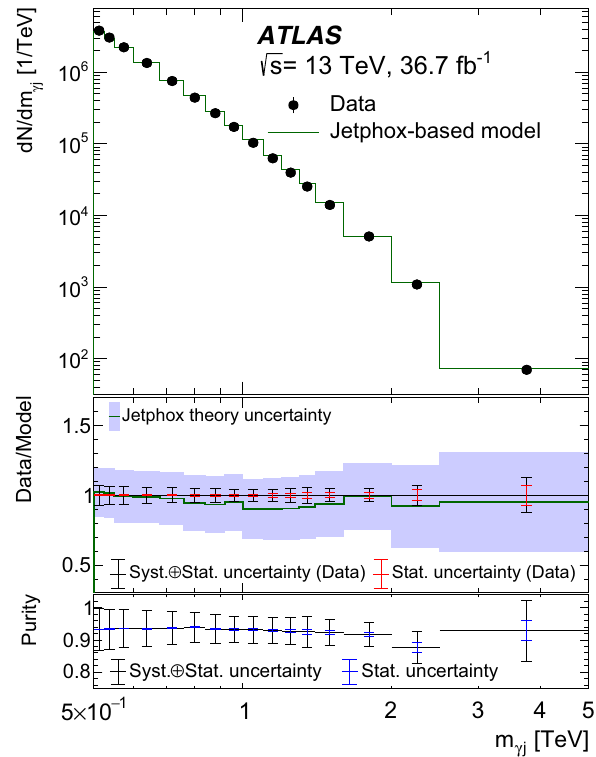
Fig. 3 Distribution of the invariant mass of the γ + jet system as mea- sured in the γ + jet data (dots), compared with the Jetphox (green his- togram) γ + jet predictions. The Jetphox distribution is obtained after correcting the parton-level spectrum for showering, hadronization and detector resolution effects as described in the text. The distributions are divided by the bin width and the Jetphox spectrum is normalized to the data in the m γ j range above 500 GeV. The ratio of the data to Jetphox prediction as a function of m γ j is shown in the middle panel (green histogram): the theoretical uncertainty is shown as a shaded band. The statistical uncertainty from the data sample and the sum of the statistical uncertainty plus the systematic uncertainty from the background sub- traction are shown as inner and outer bars respectively. The measured γ + jet purity as a function of m γ j is presented in the bottom panel (black histogram): the statistical uncertainty of the purity measurement is reported as the inner error bar while the total uncertainty is shown as the outer error